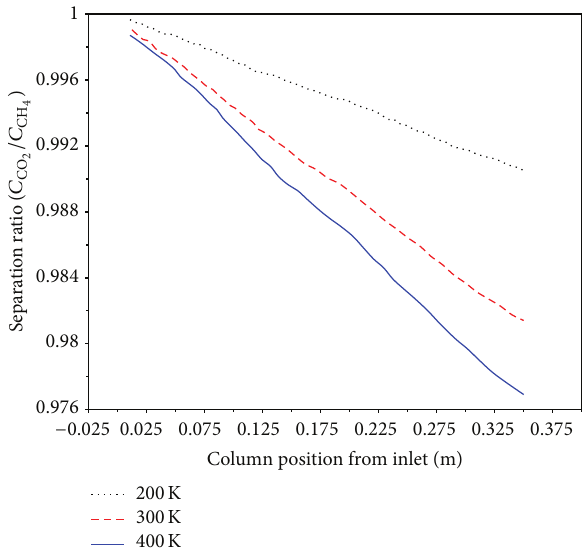
Figure 3: Concentration of methane as a function of time.